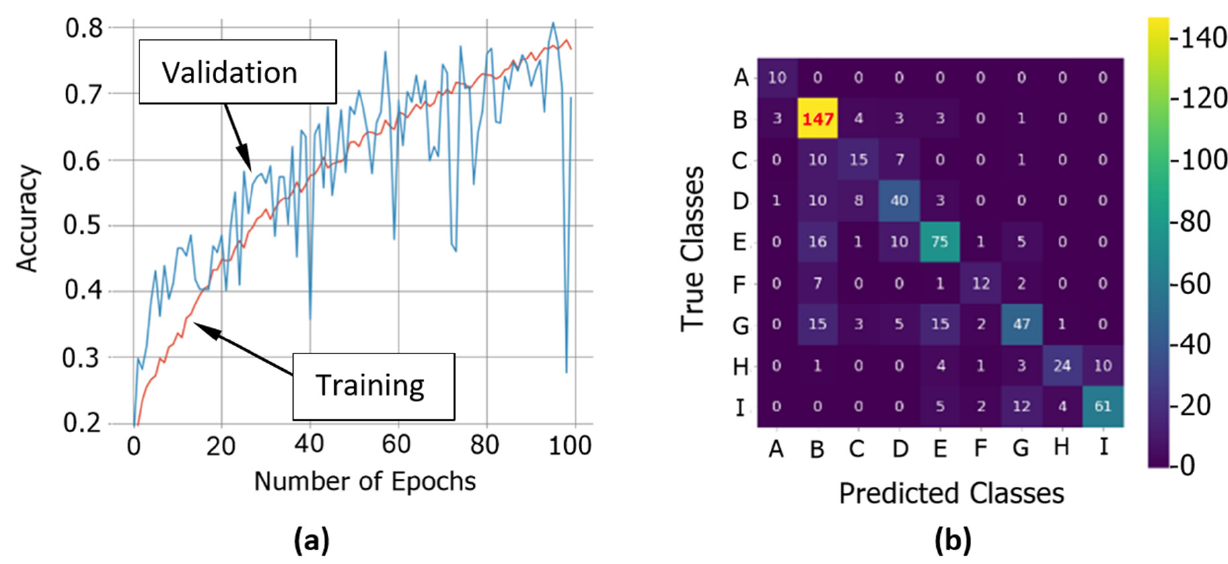
Figure 8. Graphics for VGG16 architecture. ( a ) Training and validation accuracy ( b ) Confusion matrix for Test set. Apple variety legend: (A) Blanquina, (B) Carri ó , (C) Florina, (D) Fuentes, (E) Prieta, (F) Raxao, (G) Reineta Encarnada, (H) Reineta Pinta, (I) Reineta Roja del Canad á